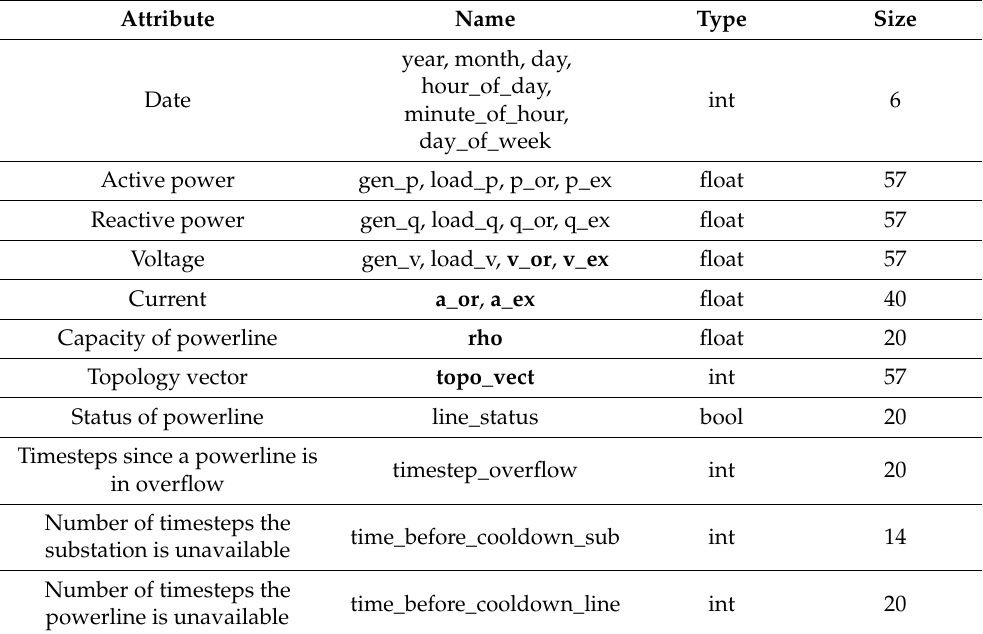
Table 4. Main observation attributes